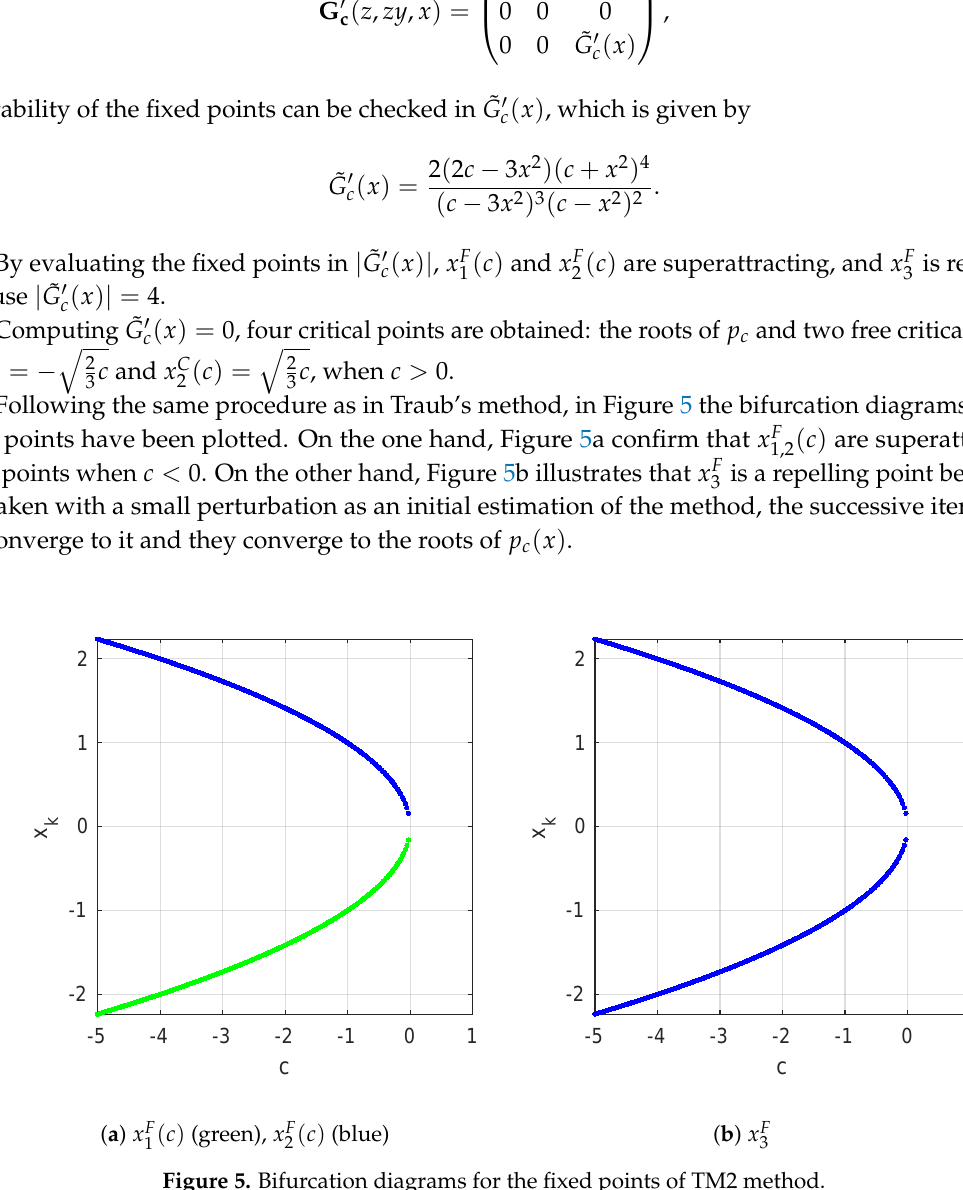
Figure 5. Bifurcation diagrams for the fixed points of TM2